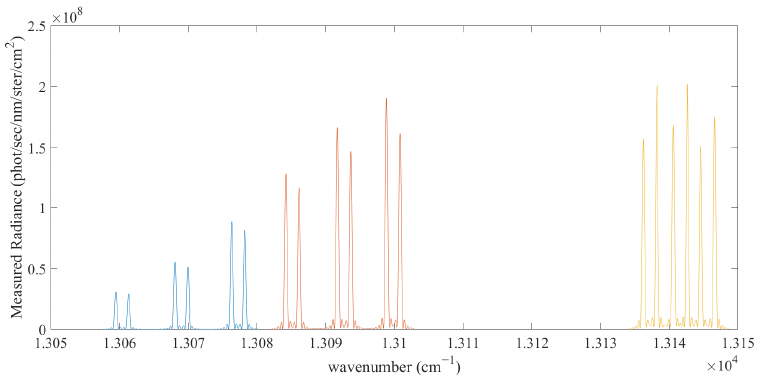
Figure 5. Simulated limb observed spectrum of target bands in field of view of 92 km (spectra in different color are band 1–3 successively).